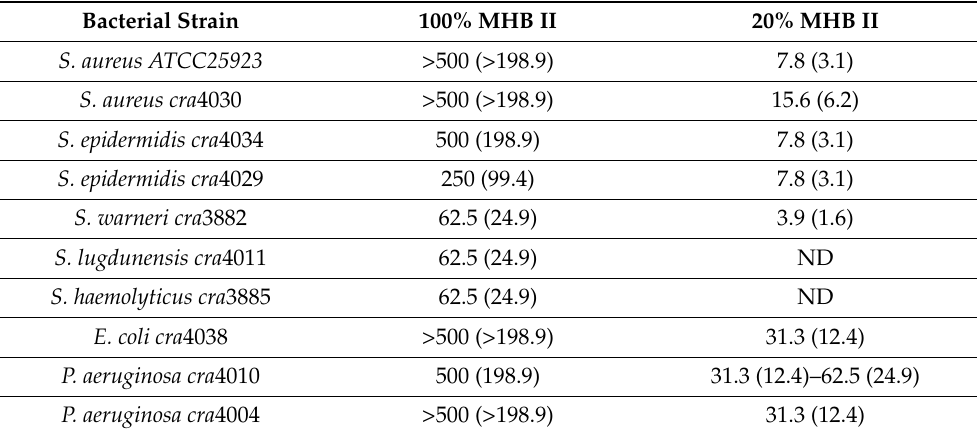
Table 3. MBIC values obtained in undiluted and diluted MHB II.